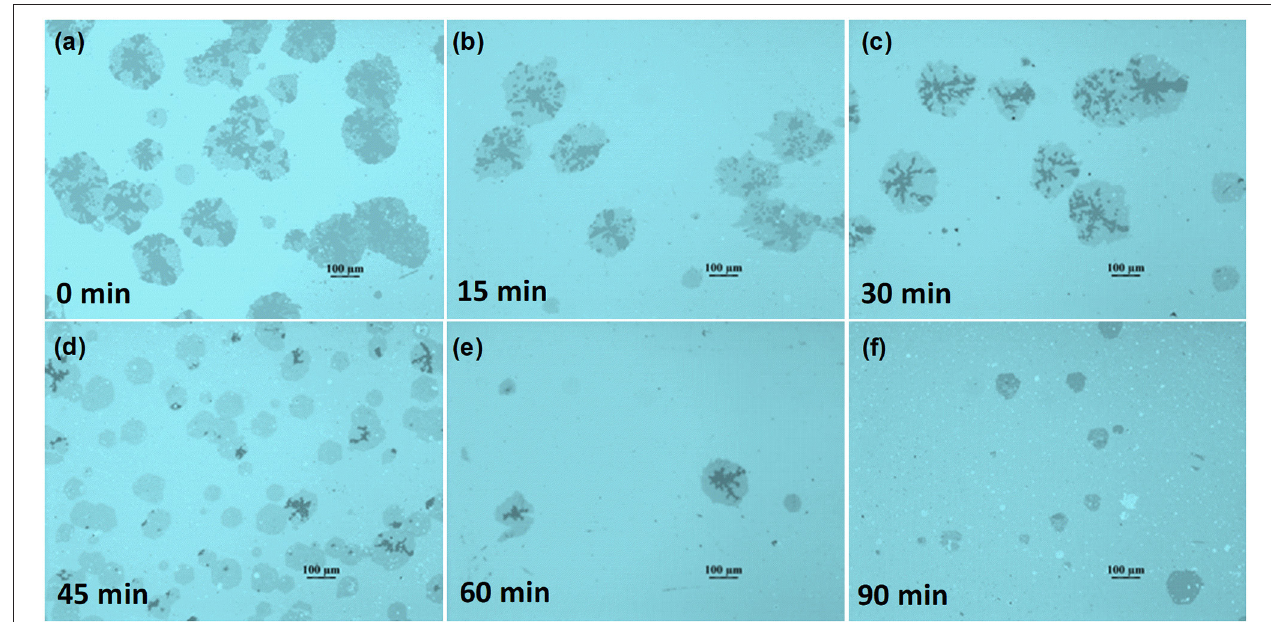
FIGURE 3 | Optical images of graphene domains with 30min growth after being transferred on the SiO 2 /Si surface. The corresponding substrate was Cu foil with an oxide layer pretreated with different annealing times in Ar/H 2 . (a) 0, (b) 15, (c) 30, (d) 45, (e) 60, and (f) 90min.